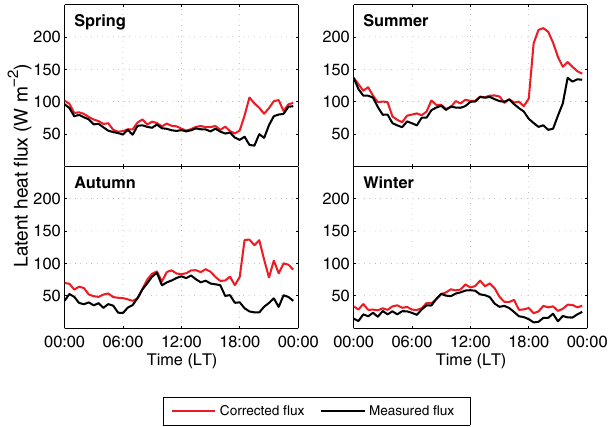
Figure 4. Median diurnal cycles of the measured latent heat flux (black lines) and the latent heat flux corrected with the multiple regression model for wind directions between 230 and 330 ◦ (red lines).